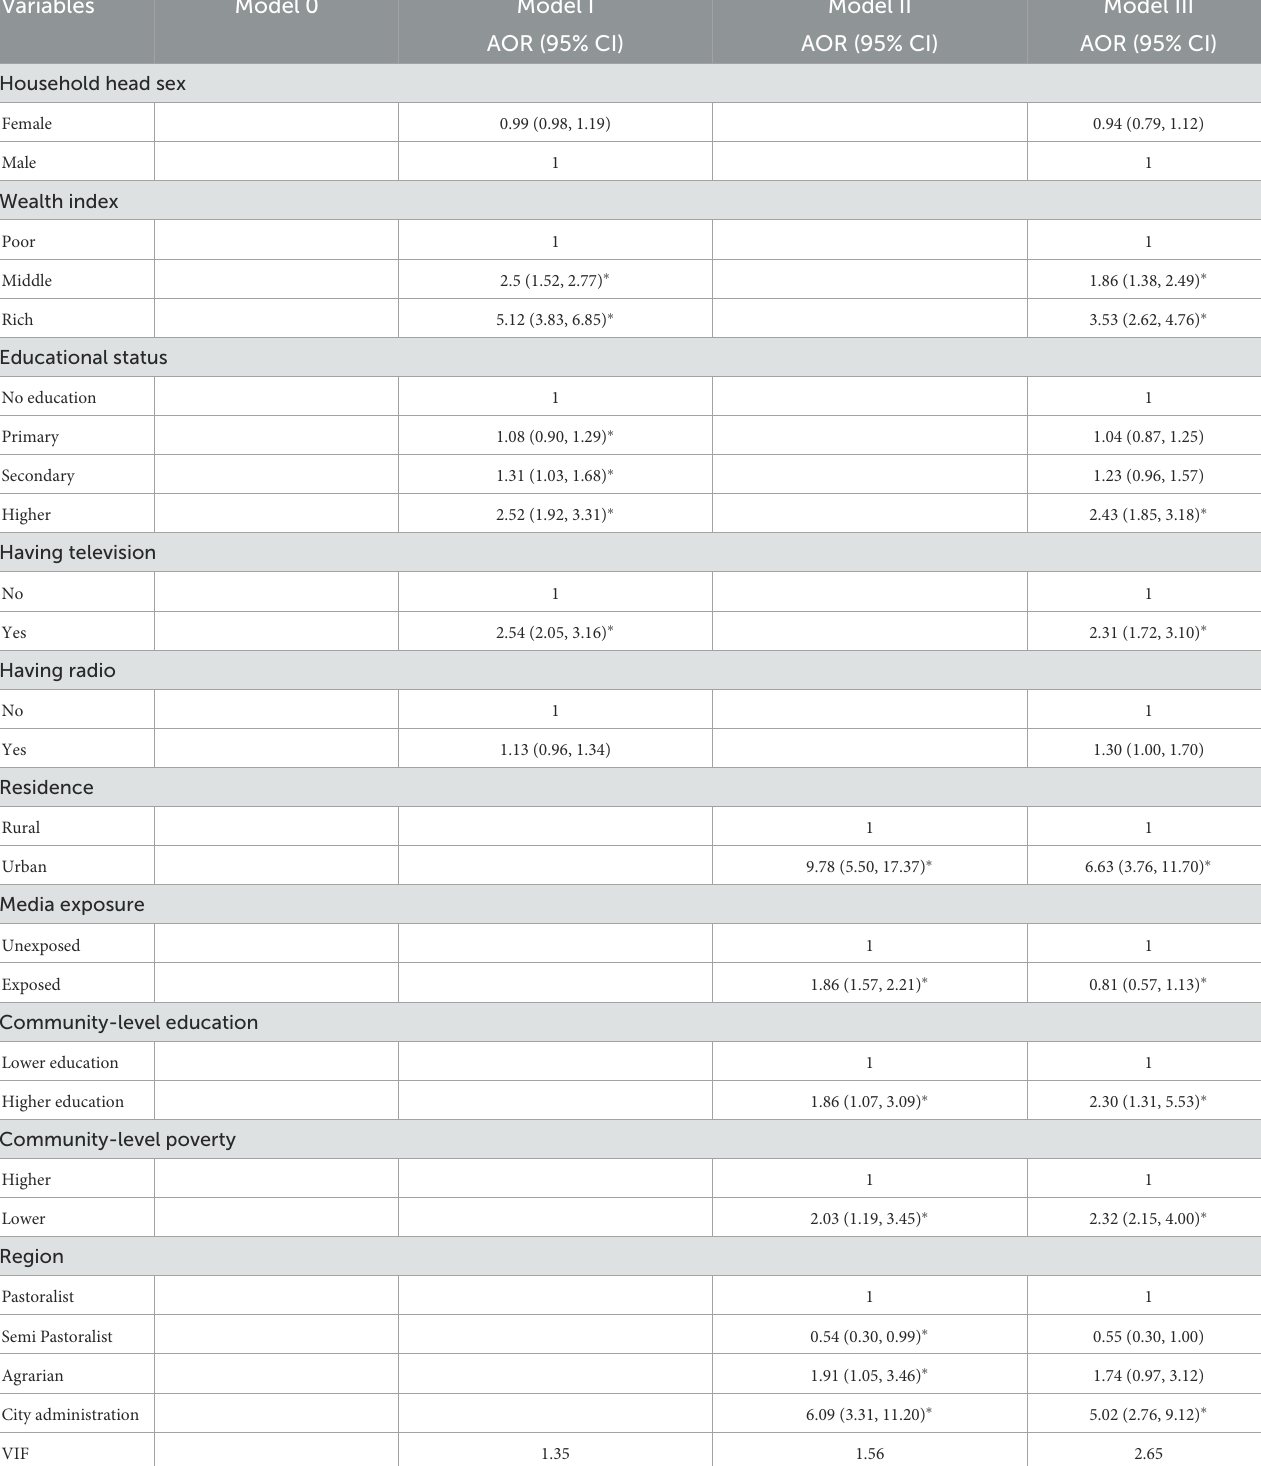
TABLE 5 Multilevel regression analysis improved sanitation predictors variables in Ethiopia, EMDHS